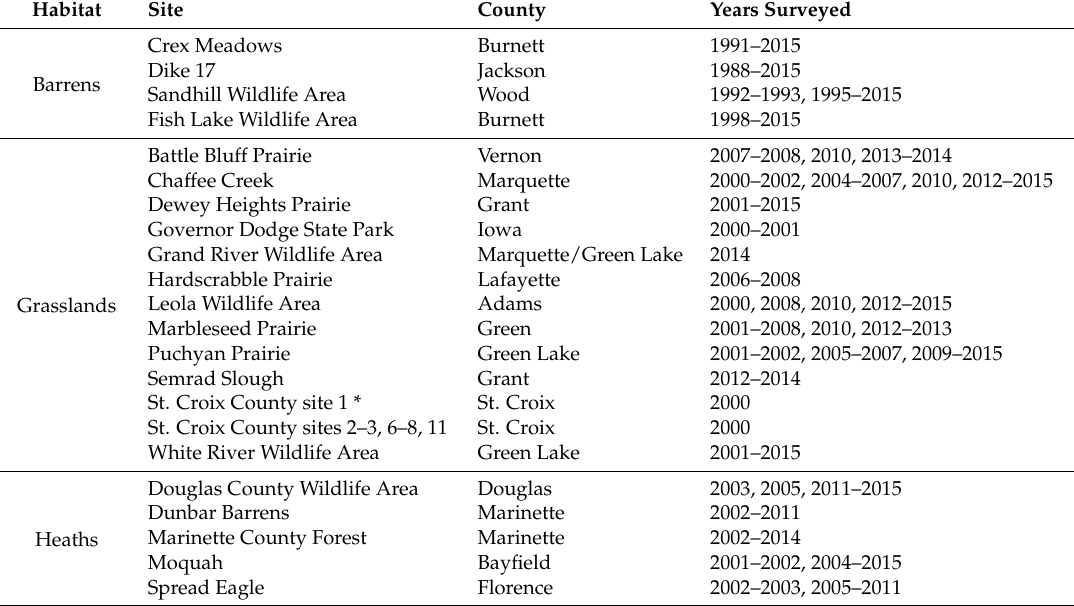
Table A1. Sites of plausible habitat surveyed during 2000–2015 during the expected flight period for that area, but with no regal fritillaries recorded. This is additive to the compilation in [32]. Habitat Site County